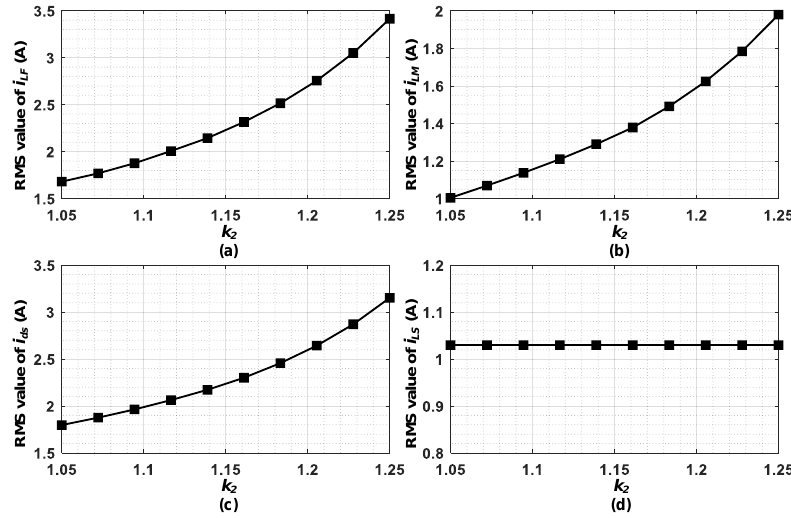
Figure 8. RMS values of branch currents under different k 2 values when selecting k 1 = 10. ( a ) RMS values of i LF ( t ); ( b ) RMS values of i LM ( t ); ( c ) RMS values of i ds ( t ); ( d ) RMS values of i LS ( t ).